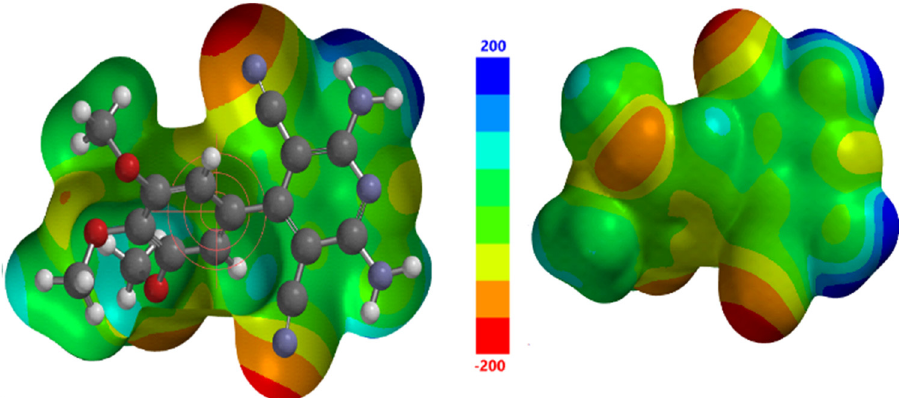
Figure 9: The MESP surfaces of the studied compounds.